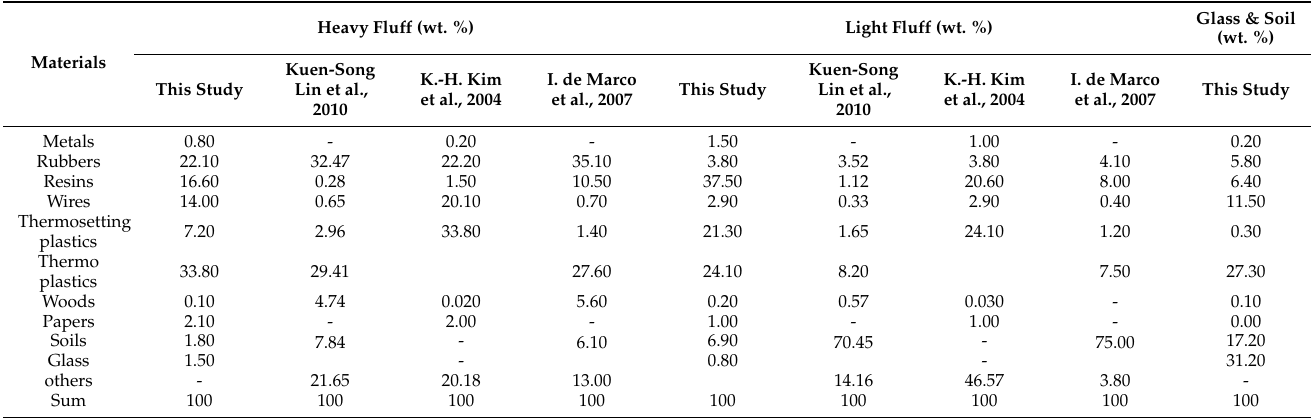
Table 1. Physical composition of ASR tested.